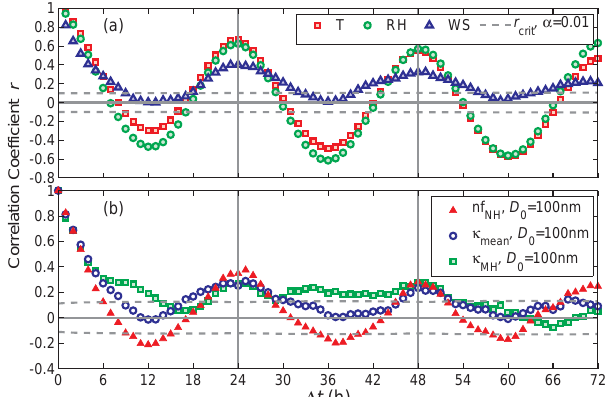
Fig. 4. Autocorrelation analysis of meteorological parameters and hygroscopic properties of 100nm particles. (a) temperature (T ) , relative humidity (RH) and wind speed (WS); (b) number fraction of nearly-hydrophobic group (nf NH ) , mean κ ( κ mean ) and κ of more hygroscopic group ( κ MH ) . The dashed lines show the significance level of 0.01.